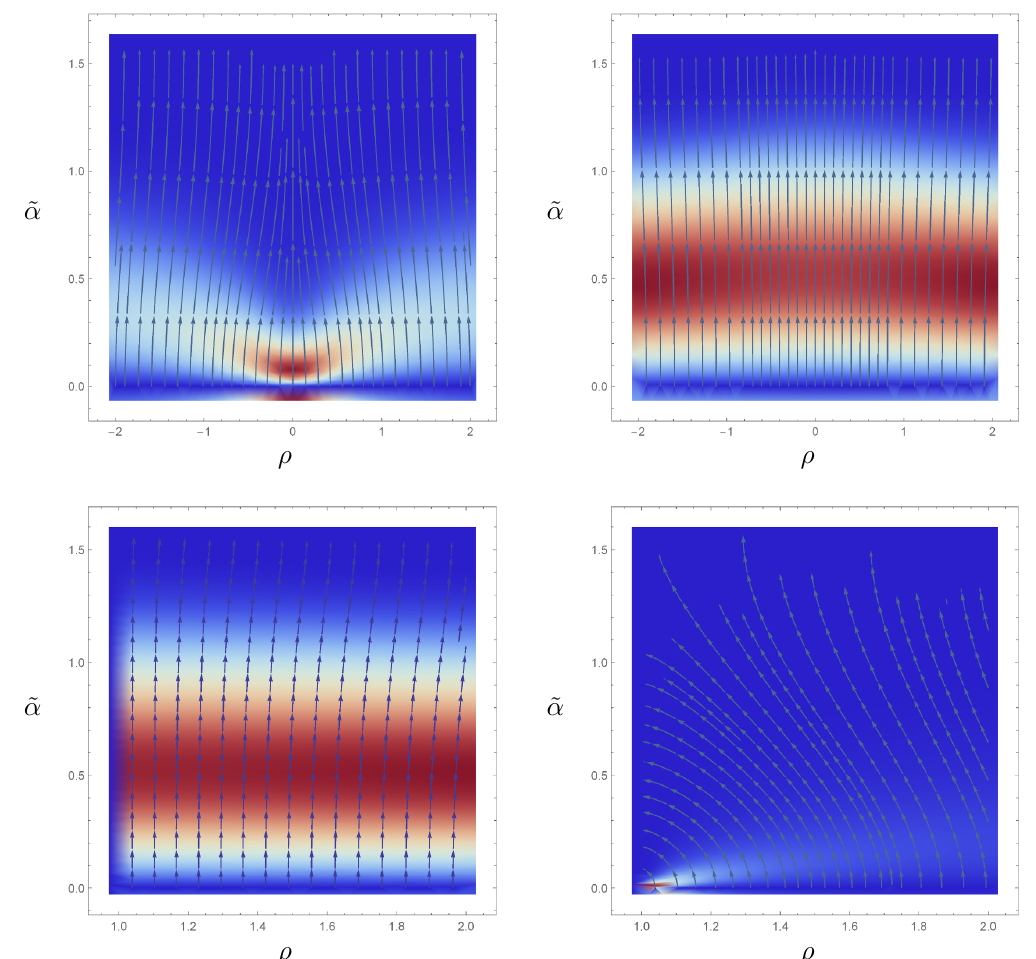
p Figure 8 . Plots of the vector field v = ( g ρ 2 ± 1 ∂ ρ ˆ α , ∂ ˜ α ˆ α ) on the strip spanned by ( ρ, ˜ α ) . The + sign must be chosen for the Janus solutions whereas the − sign corresponds to the Hades solutions p as a consequence of the change of radial coordinate dρ = g ρ 2 ± 1 dµ . Top-Left: Janus flow with α = 1 and β = 0 . Top-Right: Janus flow with α = 1 and β = π . Bottom-Left: ridge flow with β = − π . Bottom-Right: ridge flow with β = π 2 2